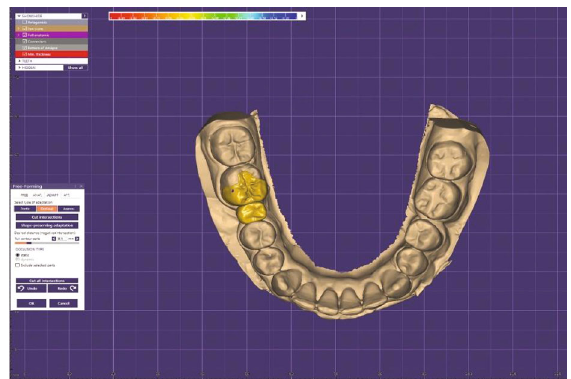
Figure 5: Computer-aided designed framework (occlusal view).